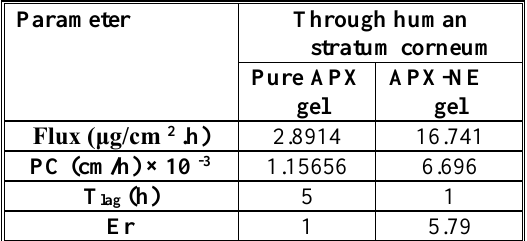
Ex vivo permeation data analysis Permeation parameters of APX-NE gel Table 3. Permeation parameters results of APX- NE